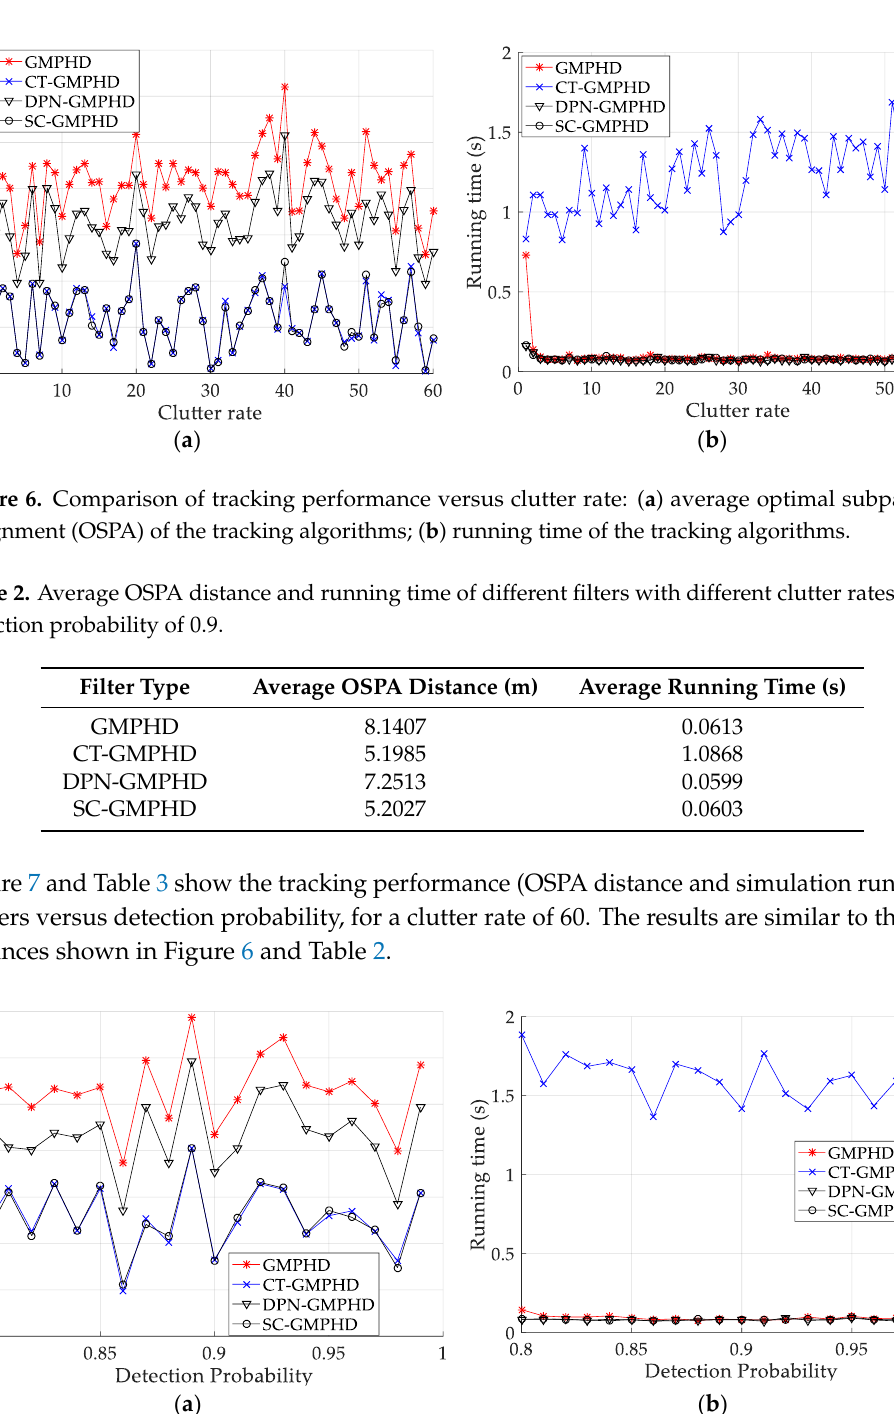
Figure 7. Tracking performance of the filters versus detection probability: ( a ) average OSPA of the filters; ( b ) running time of the filters. Table 3. Average OSPA distances and running times of different filters versus detection probability, for a clutter rate of 60.